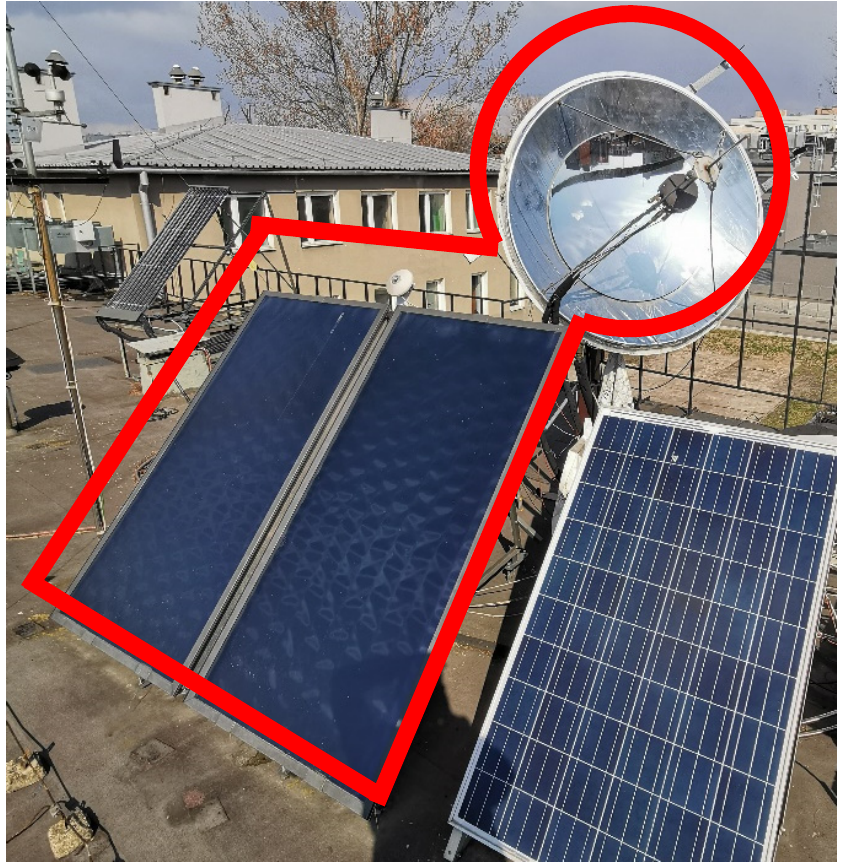
Figure 1. Parabolic dish concentrator with two focusing elements: bowl lined with reflective foil and parabolic mirror.